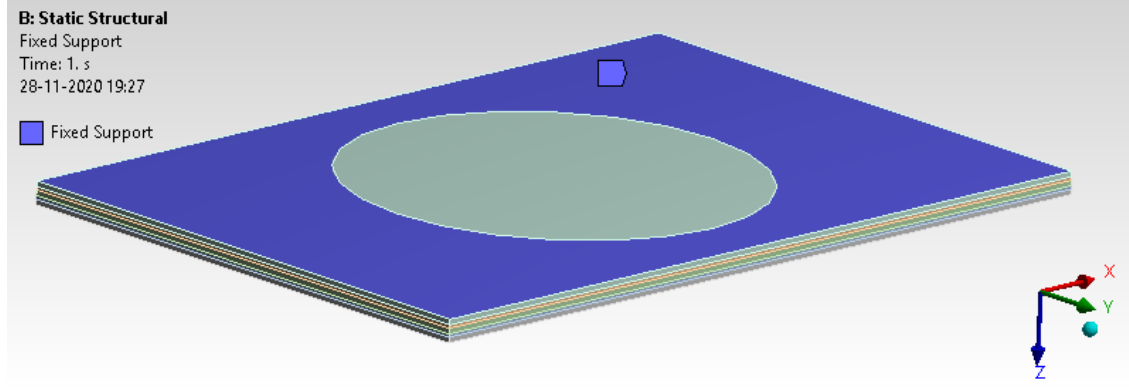
Figure 16. Boundary condition.